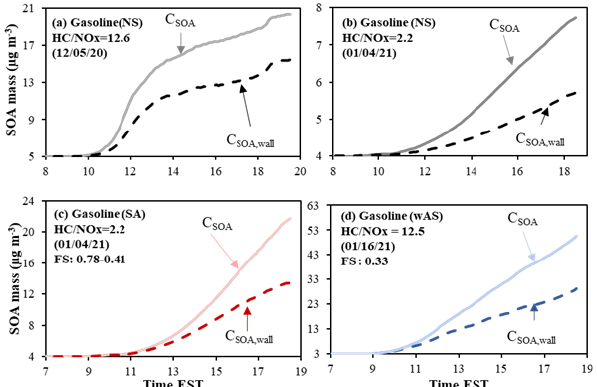
Figure 5. The comparison of gasoline SOA mass ( C SOA , wall ) in the presence of GWP and gasoline SOA mass ( C SOA ) in the absence of GWP. SOA formation was simulated using UNIPAR-CB6r3 for the photooxidation of gasoline vapor at given experimental conditions (Table